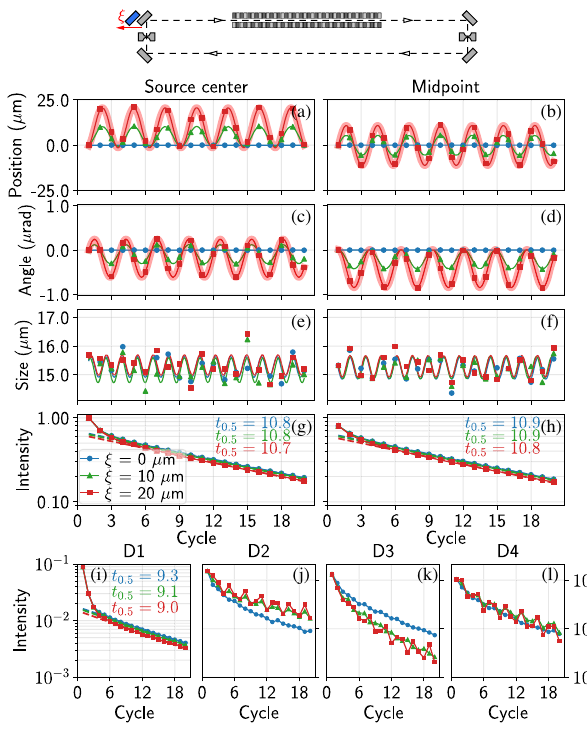
FIG. 15. Similar to Fig. 14, but with roll angle error ρ in C 4 . The dashed lines represent out-of-cavity-plane deviations.